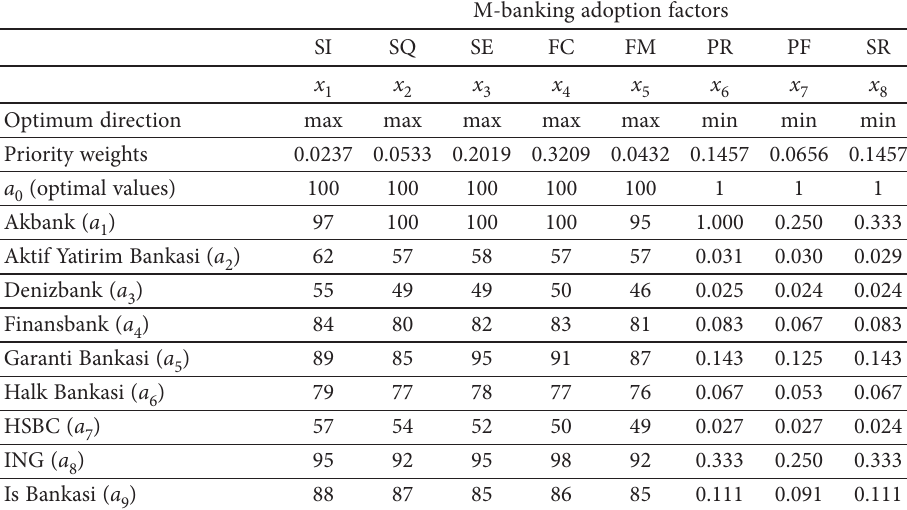
Table 11. Changed initial data for analysis (initial decision making